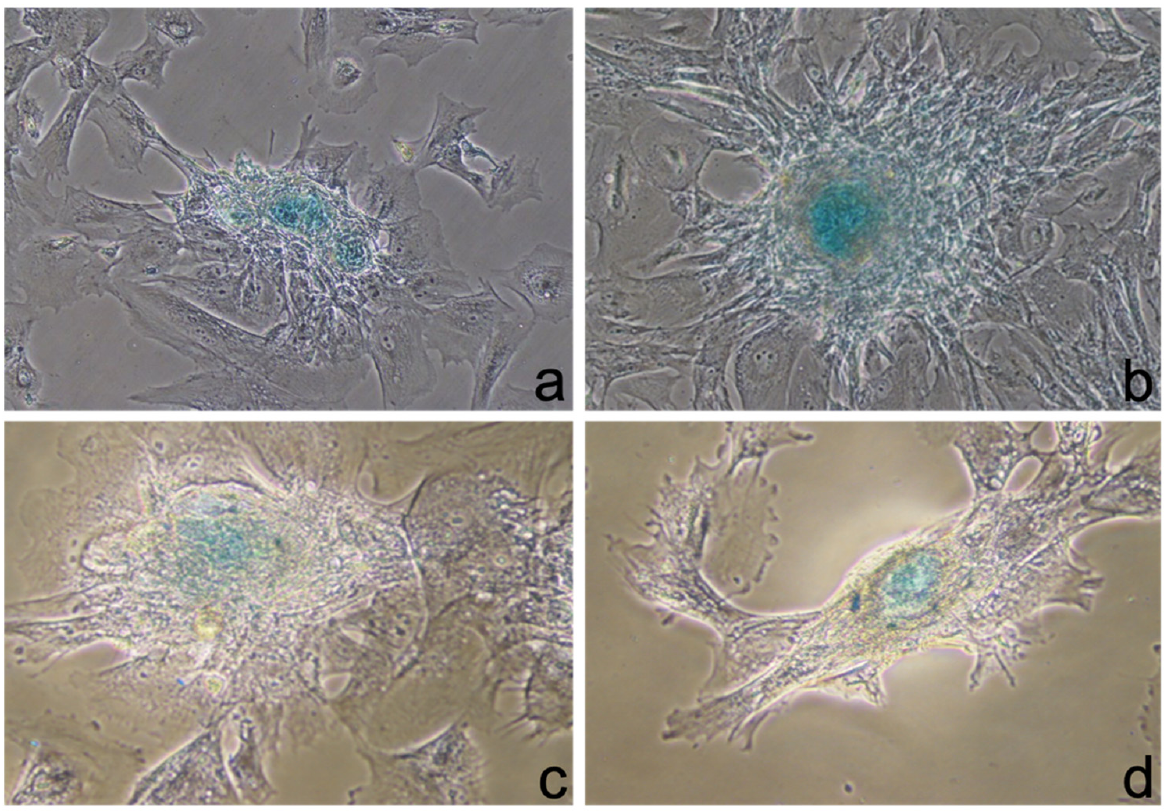
Figure 3. Alcian blue staining: ( a , b ) 10× magnification; ( c , d ) 20× magnification.